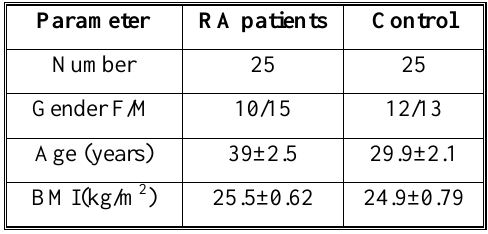
Table 2: Mean±standard error of nitric oxide, peroxynitrite, malondialdehyde, uric acid and erythrocyte sedimentation rates of patients with rheumatoid arthritis and healthy controls group